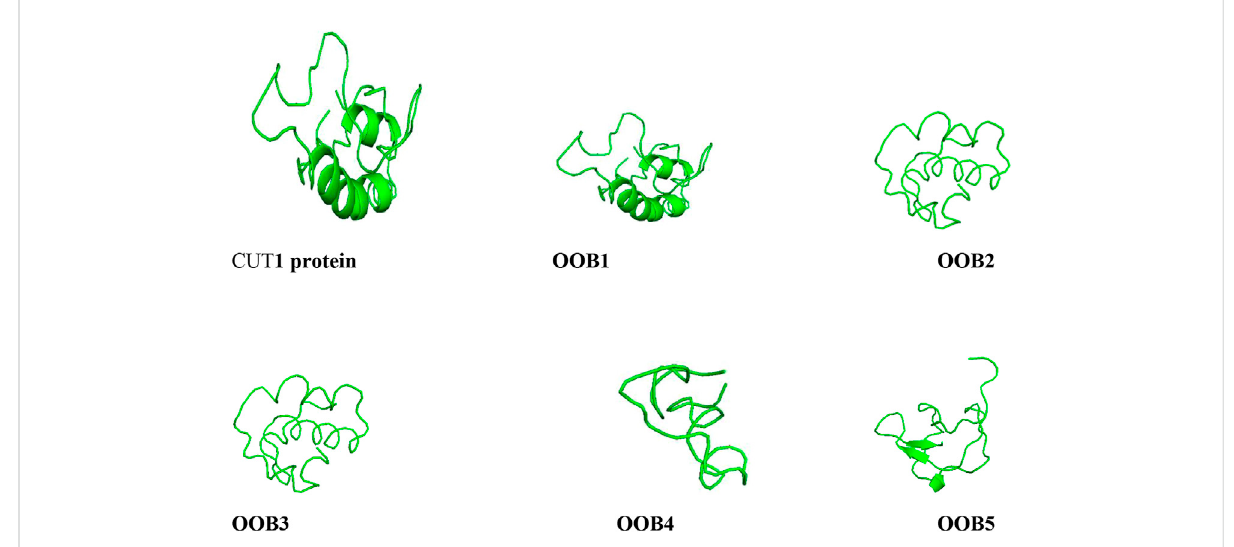
FIGURE 3 Structures of the anti- Fusarium solani AMPs and Fusarium solani cut1 protein all represented in ash colour visualized using PyMol.